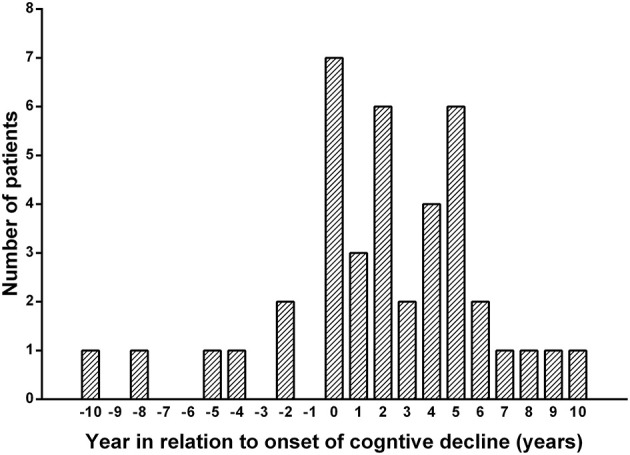
Onset of epilepsy in relation to the onset of cognitive decline. The yearly distribution of new-onset seizures relative to the year of onset of cognitive decline: the median duration between the onset of cognitive decline and the onset of epileptic seizures was 2 years (range −10 to 10 years), with 80% of people (n = 32/40) experiencing their first epileptic seizures within the time frame ranging from 2 years prior through to 6 years after the onset of cognitive decline.